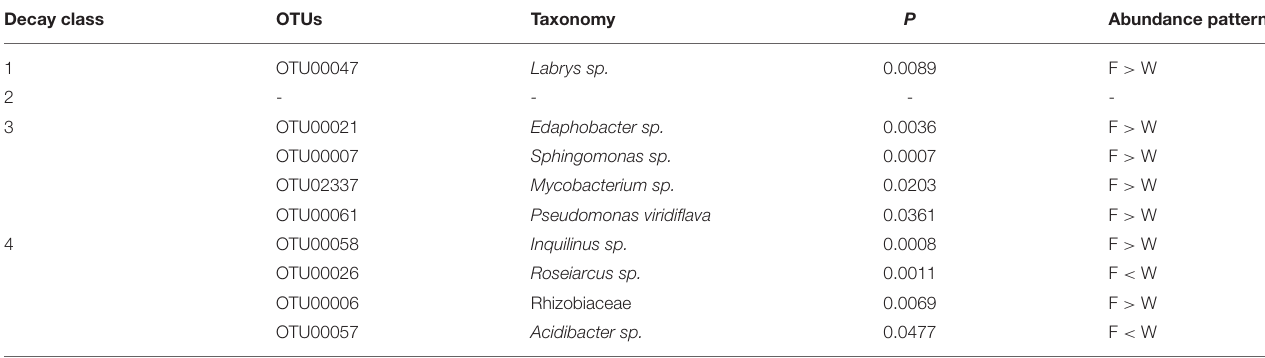
TABLE 1A | The most abundant operational taxonomic units (OTUs) in top 50 showing significant different patterns between fruiting body (F) and wood (W) in each decay